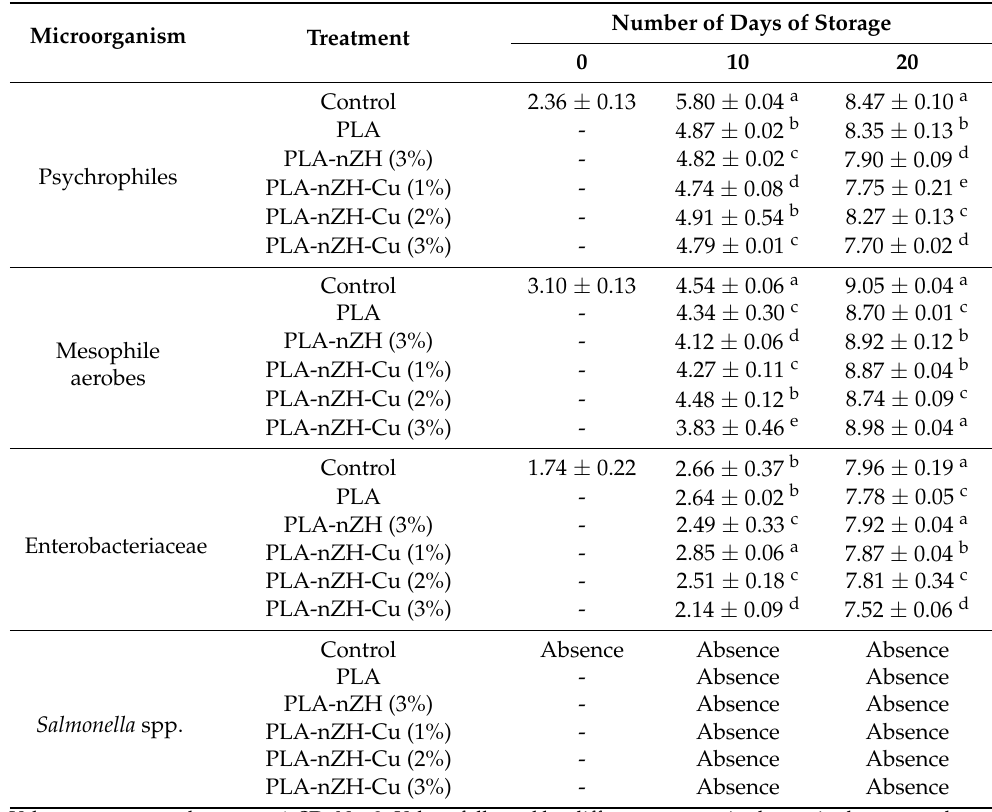
Table 2. Microbial count (CFU/mL Log10) for chicken breast meat in contact with PLA-nZH-Cu nanocomposite films during storage at 4 ◦ C for 20